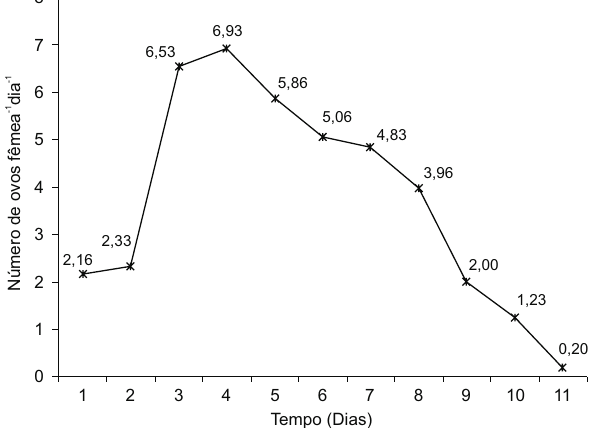
Figura 1. Taxa de oviposição de T. desertorum em folhas de feijão ( P. vulgaris ) cultivar “Tacarigua” a 28 ± 2ºC, 70 ± 10% U.R. e 12:12h (média de 30 observações), em